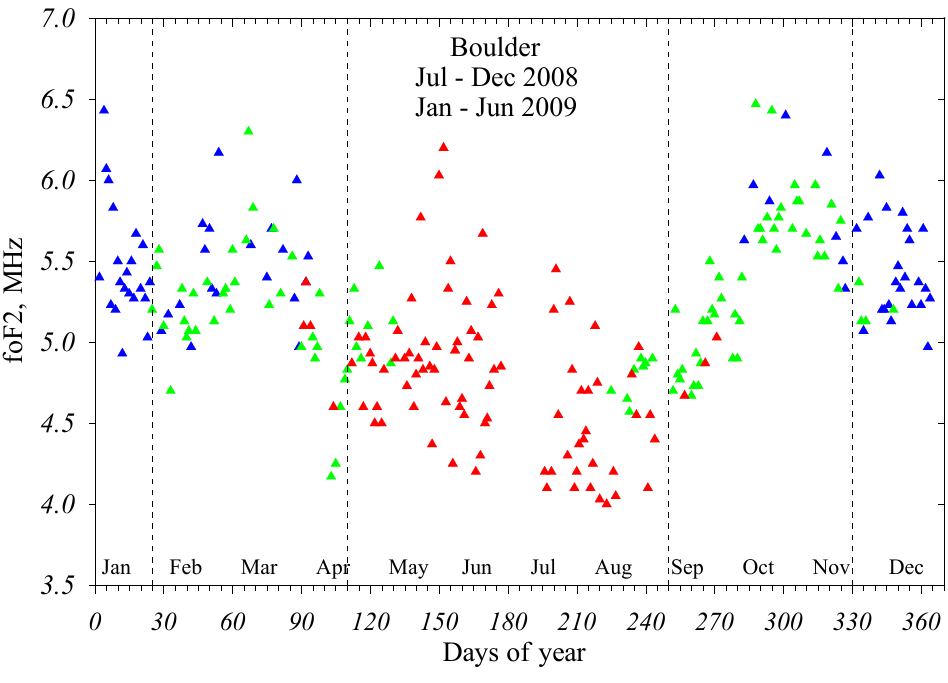
Figure 4. Same as Figure 3 but for Boulder.